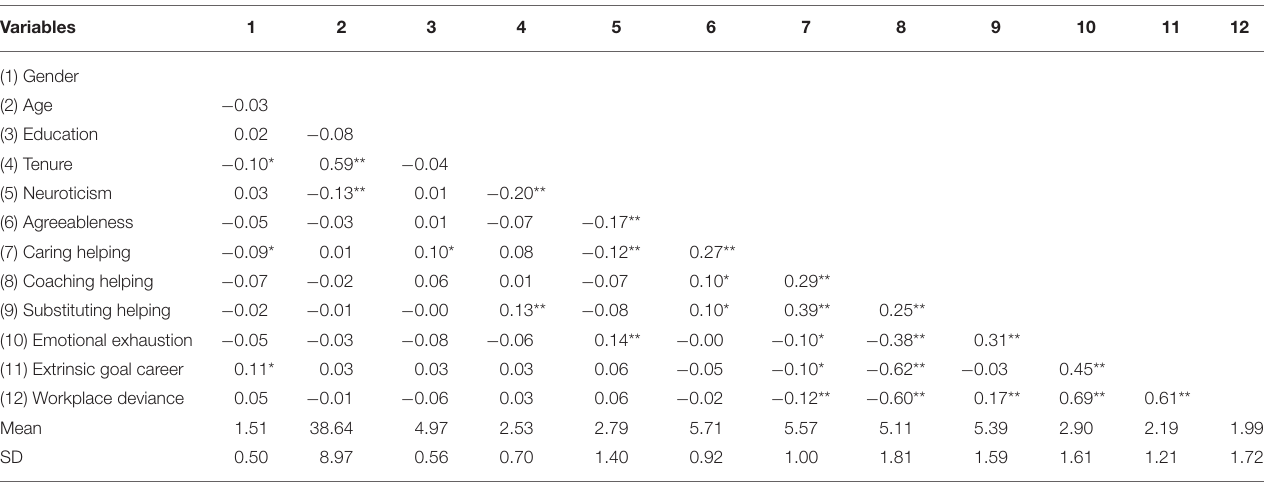
TABLE 1 | Descriptive statistics and correlations among all variables.